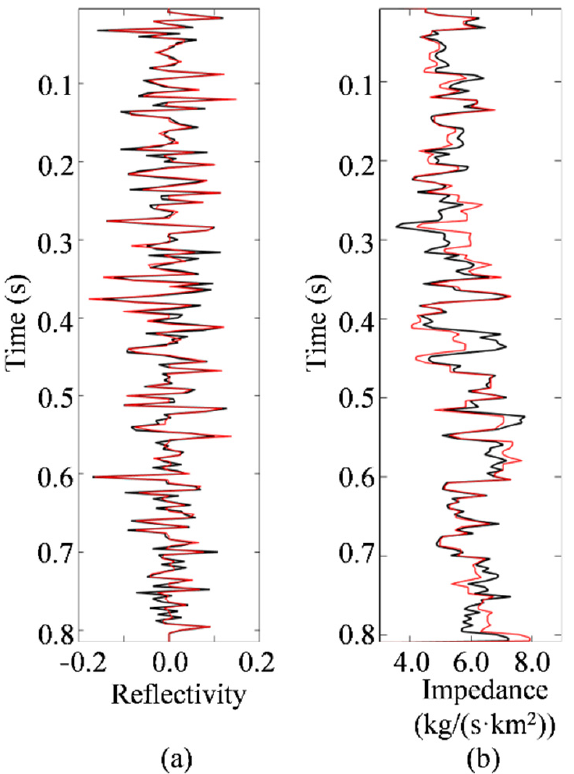
Figure 4. The inverted reflectivity series and impedances from L1R1 performed on the noise-free synthetic trace. ( a ) Reflectivity series; ( b ) impedance.